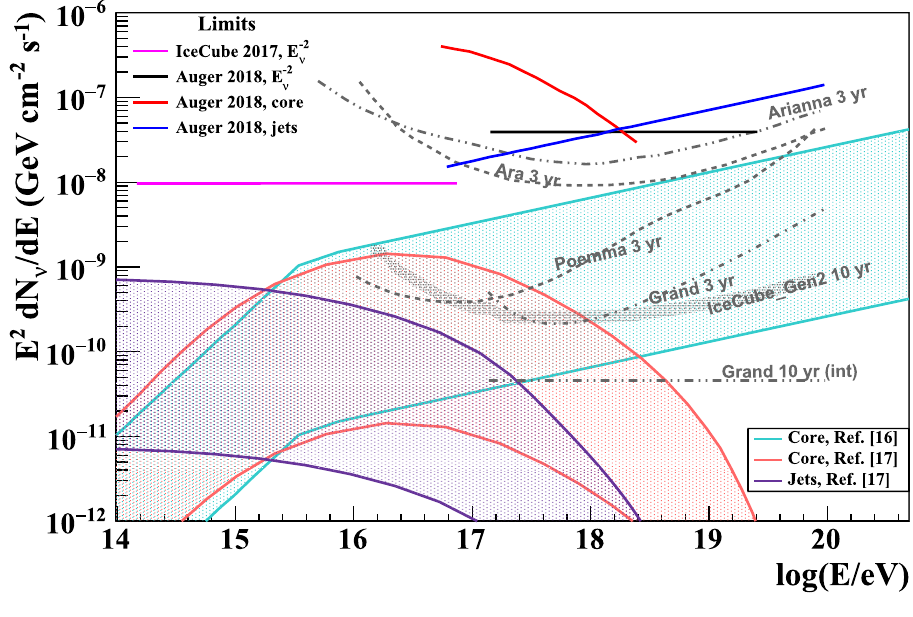
fifteen astrophysical scenarios are considered